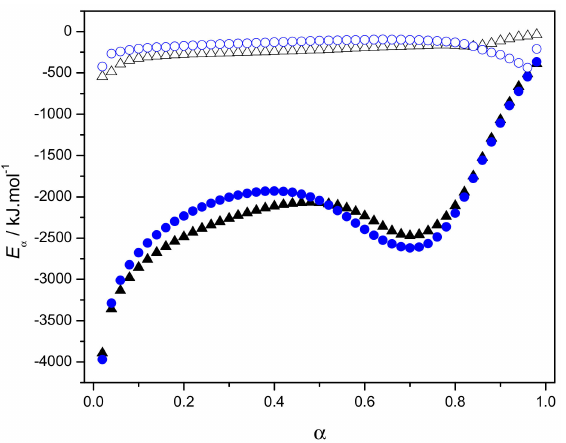
Figure 7. E α dependence vs. relative degree of crystallinity computed from FSC and DSC data. Black triangles: PTFE; blue circles: PTFE / SiO 2 (c)F; open: Crystallization performed at the cooling rates 500, 1000, 2000 and 5000 K · s − 1 ; solid: Crystallization performed at the cooling rates 0.0167, 0.0333, 0.0833, and 0.3333 K · s −